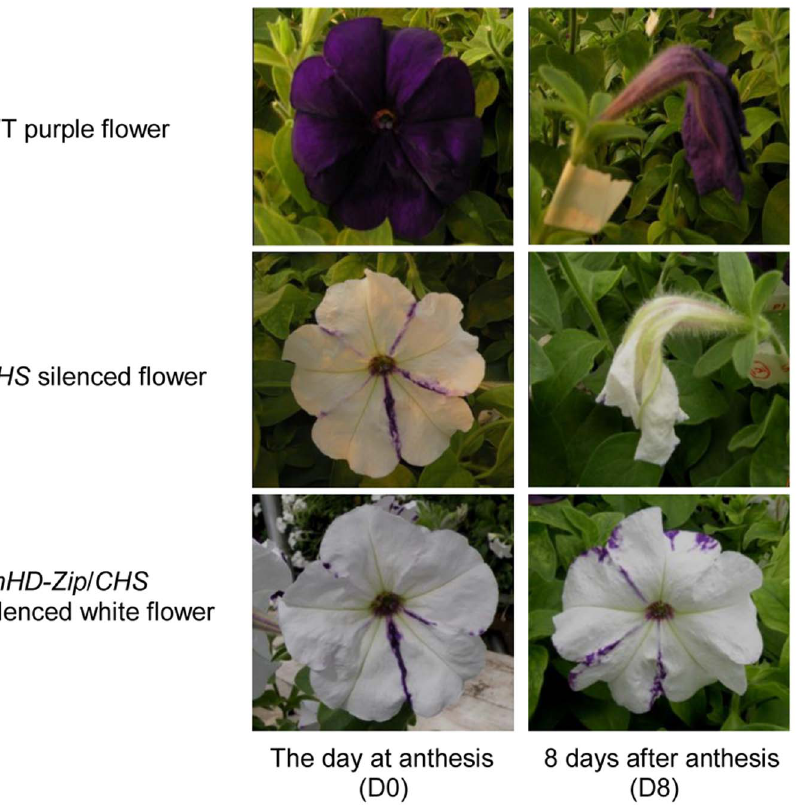
Figure 5. Effect of silencing PhHD-Zip on longevity of petunia flowers. Photographs were taken on D0 and D8 of attached purple control flowers (WT), white (silenced) flowers of plants inoculated with the CHS /TRV reporter construct, and white (silenced) flowers of plants inoculated with the PhHD-Zip / CHS /TRV silencing construct.